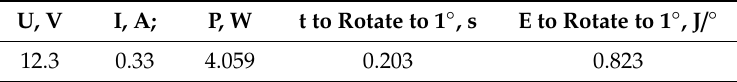
Table 3. Power performance of motor.